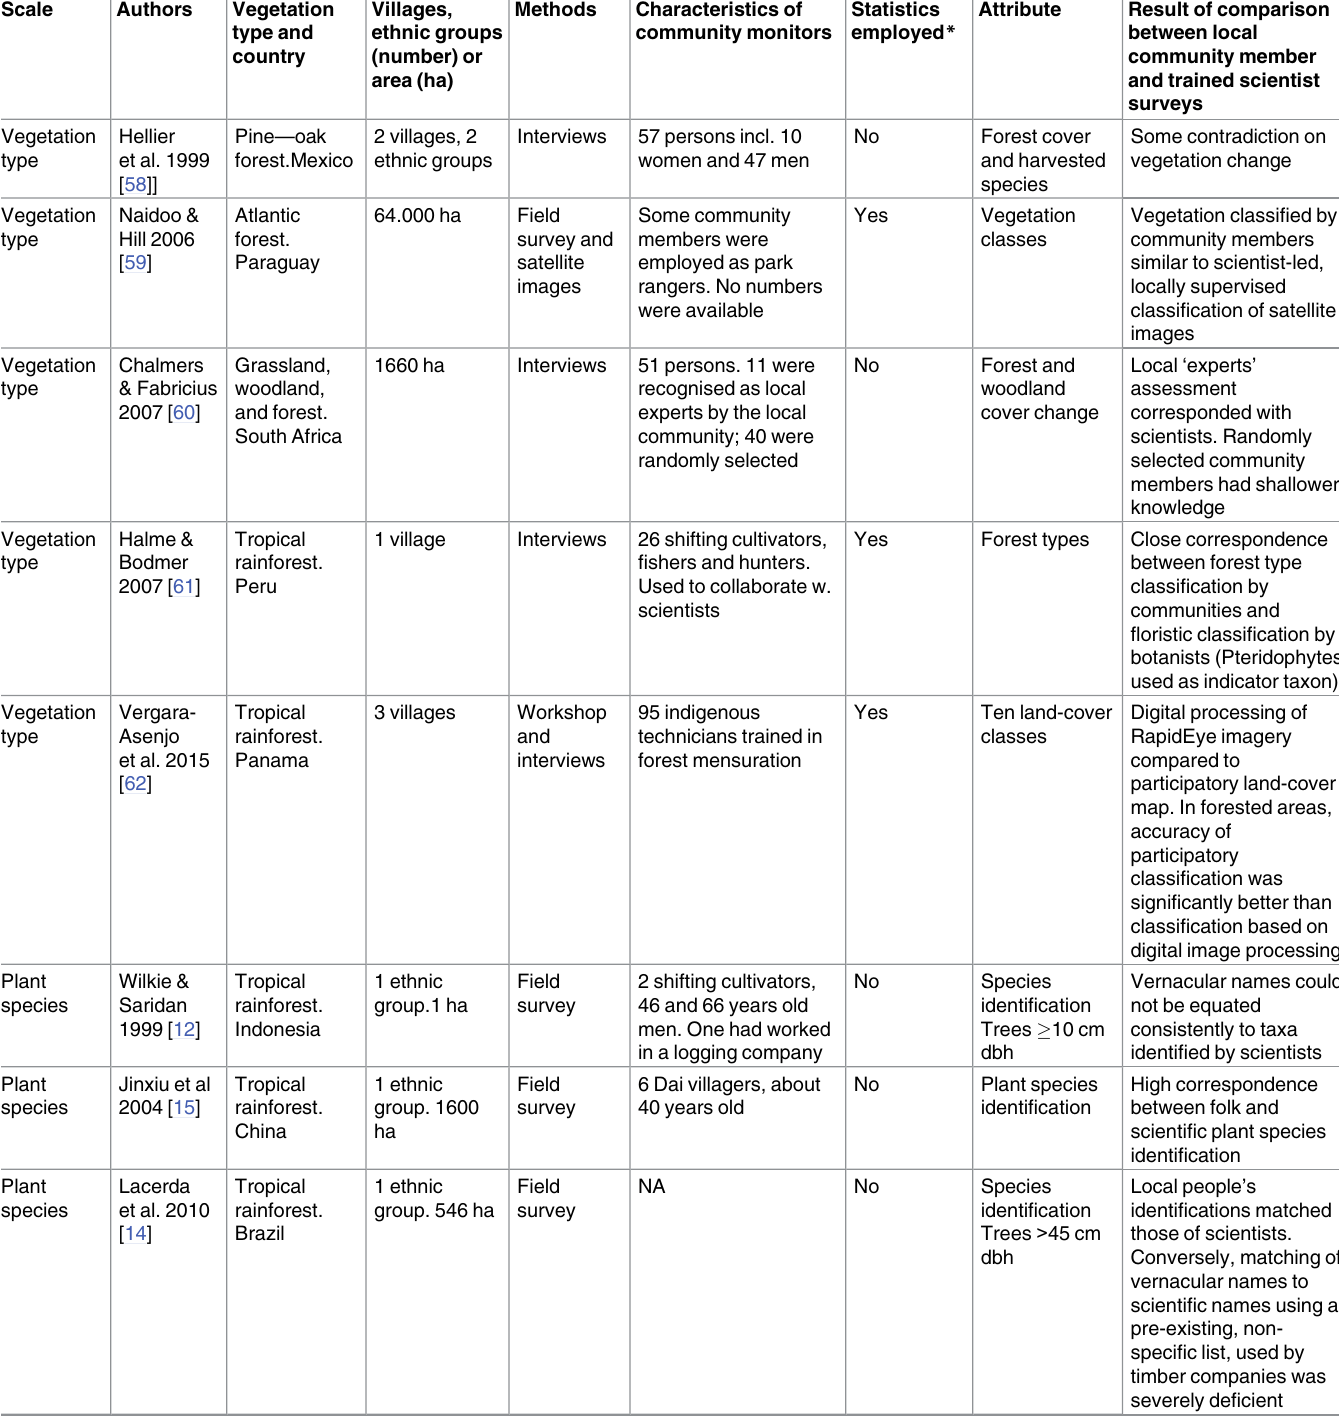
Table 1. Previous scientific studies comparing community members’ classification of vegetation and identification of plant species to those of